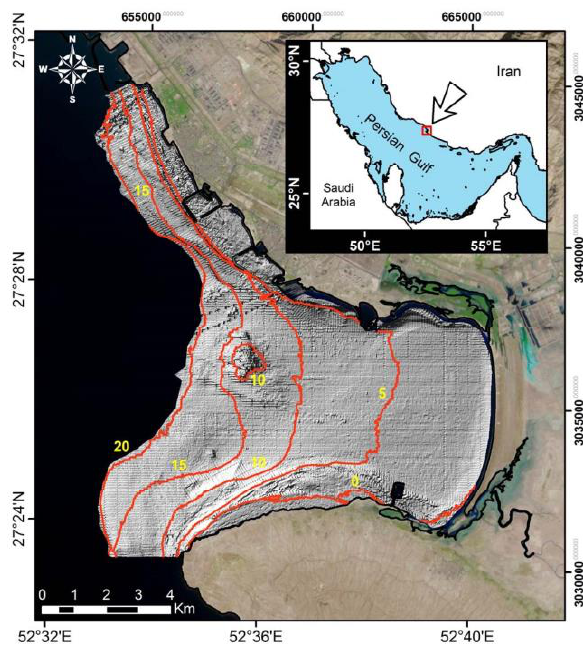
Figure 1. Bathymetric information of the Nayband Bay in the southern Iran. Projection system is UTM-Zone 39